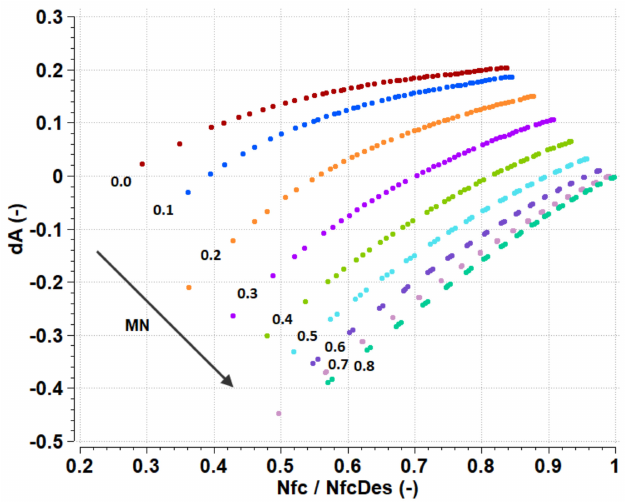
Figure 10. UBGF VAN